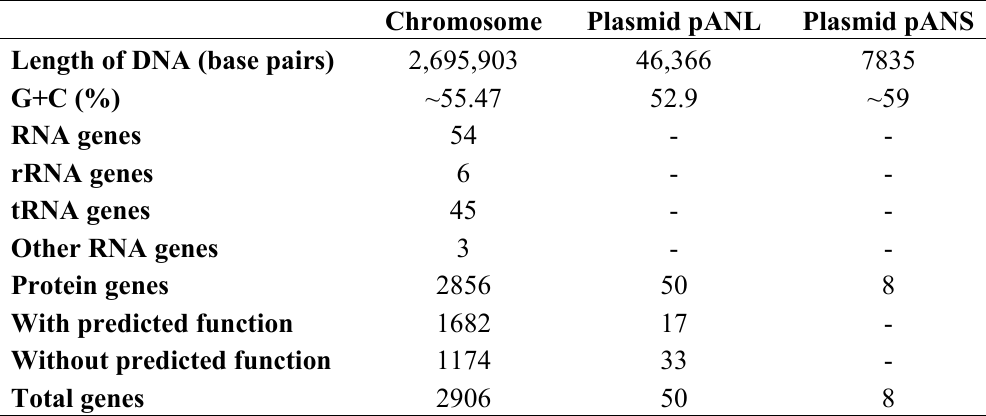
Table 1. Summary of genome features of Synechococcus elongatus PCC7942.